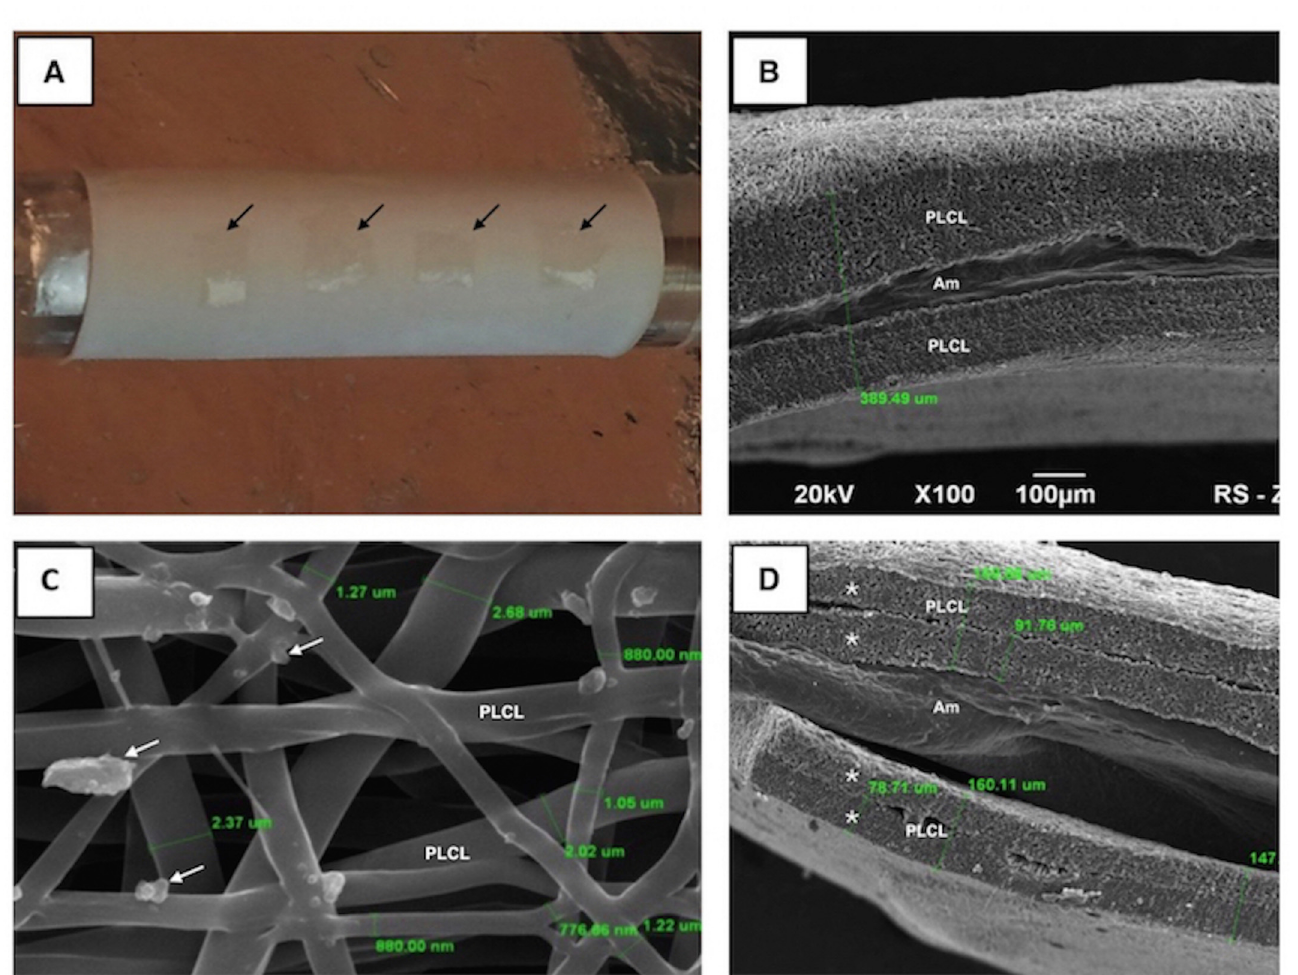
Fig 1. Preparation and structure of biocomposite. (A) The pieces of Am (black arrows) placed onto a sheet of PLCL nanofibers. A drum is used as a target during the nanofiber production process. SEM images are displayed in B-D. (B) A cross-section image of the biocomposite material. The biocomposite material is 389 um thick with an inner cavity containing the Am. (C) Visible drops of glycerin used for Am preservation are observed on surface of PLCL nanofibers (white arrows). (D) Two pieces of delaminated biocomposite material. The borders between consecutive sheets of nanofibers ( * ) are clearly visible with Am